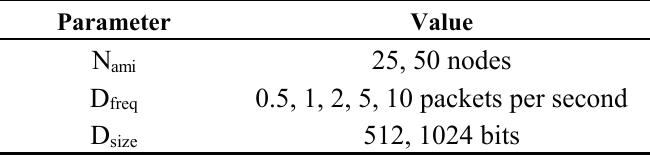
Table 6. Traffic parameter settings of protocol set